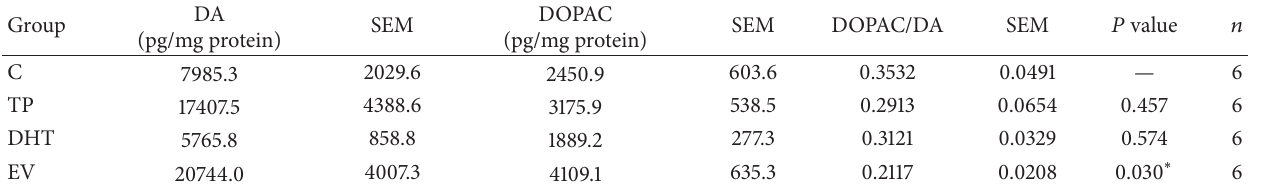
Table 1: Substantia nigra-ventral tegmental area (SN-VTA) DA and DOPAC levels from control, TP, DHT, and EV adult male rats.